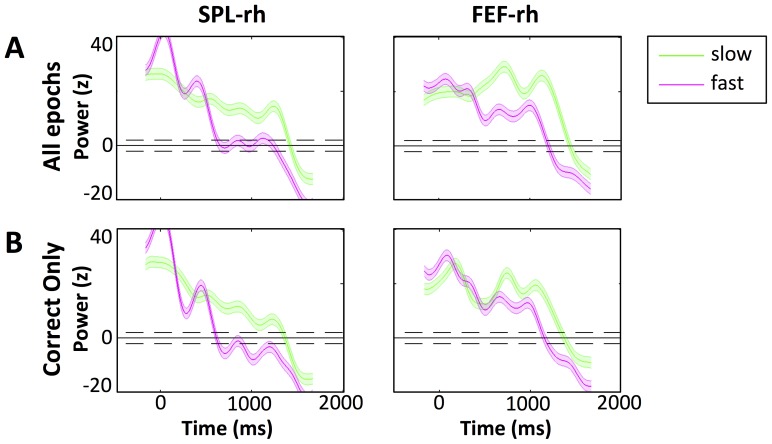
Time courses of 10 Hz alpha band oscillatory power in SPL and FEF with respect to the target speed.Fast (absolute speed greater than 5 cm/s, pink) and slow (absolute speed lower than 5 cm/s, green) speeds are shown in the VS task (A) averaged over all epochs and (B) averaged over correctly answered epochs. The y-axis represents the z-score of oscillatory power. The x-axis represents time in milliseconds relative to motion onset (0 ms). The blue line shows the 10 Hz power in the Exp Only condition with 2SD error shown in blue shade around the time course. The red line shows the 10 Hz power in the VS condition with 2SD error in red shade around the time course. The black horizontal line indicates z = 0, which is the average normalized baseline power. Dotted lines indicate z = 2 and z = −2 lines.